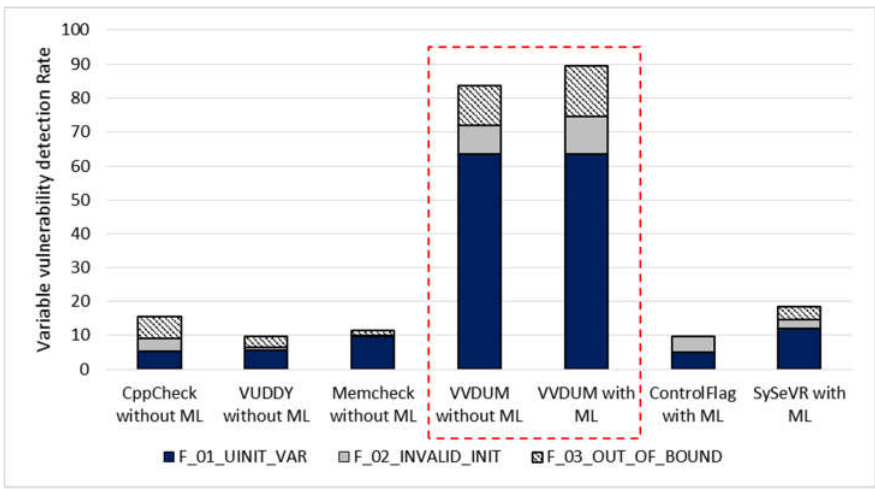
Figure 11. Comparison of results according to machine